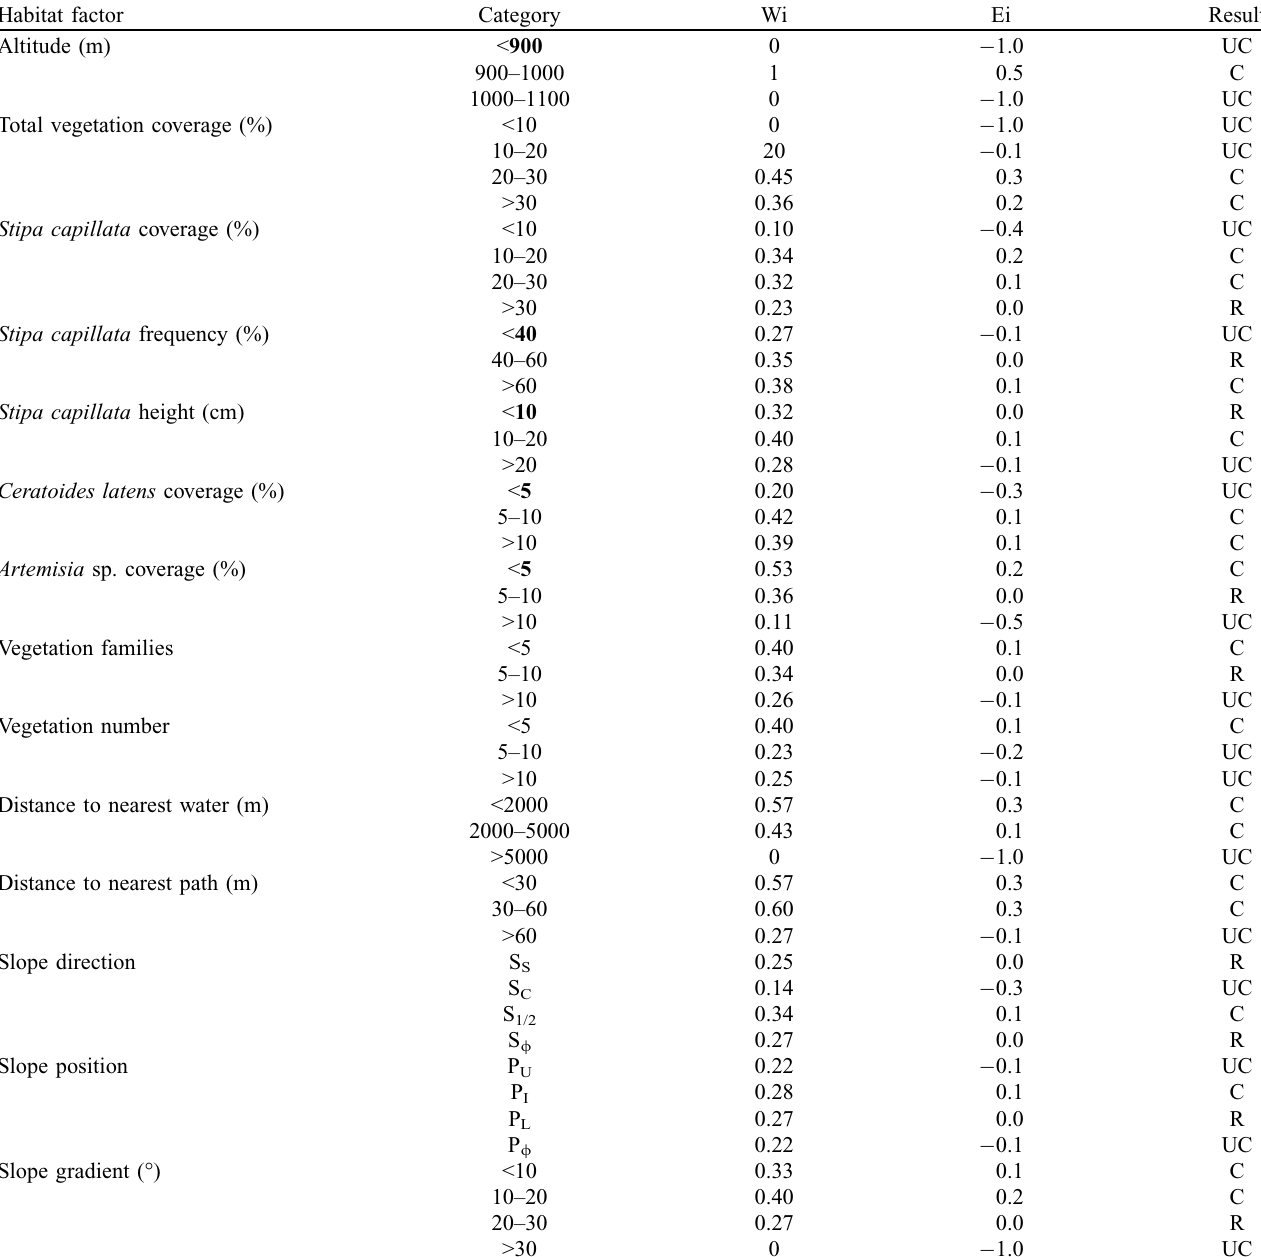
Table 2. Selective analysis and electivity index of habitat factors in oviposition site selection by G . pecorum in summer in KNR. Habitat